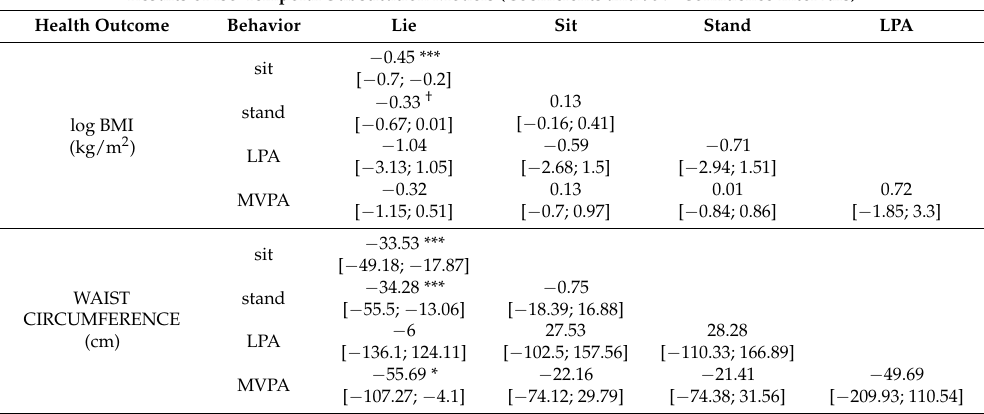
Table 3. Cont. Results of iso-Temporal Substitution Models (Coefficients and 95% Confidence Intervals) Health Outcome